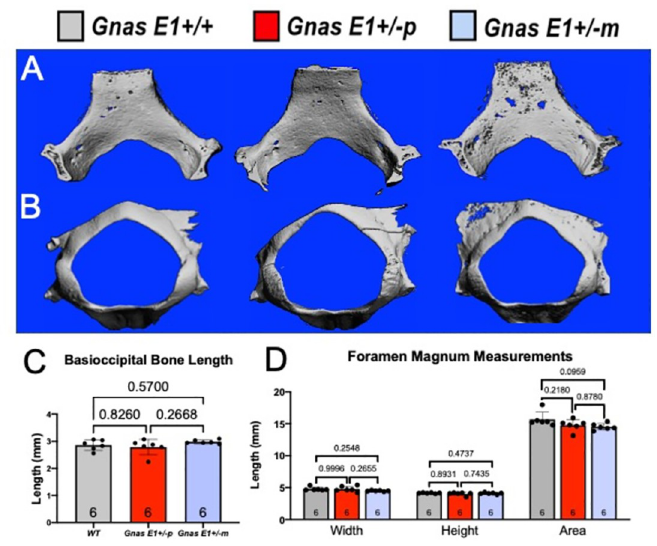
Fig 7. Gnas E1+/-m mice exhibit a reduction in foramen magnum width and area. (A, B) Representative three- dimensional reconstructions of the (A) basioccipital bone and (B) foramen magnum of 12-week old WT, Gnas E1+/-p and Gnas E1+/-m mice. (C) Measurements of basioccipital bone length in 12-week WT and Gnas E1+/- mice demonstrate no significant differences. (D) Measurement of foramen magnum width, height, and area demonstrate that Gnas E1+/-m and Gnas E1+/-p mice display no significant differences in foramen magnum width, height or total area when compared to WT mice. Sample size per genotype per experiment is listed on each graph. All statistical tests were completed using ANOVA with post-hoc Tukey test for multiple comparisons, and p -values are displayed for each comparison.